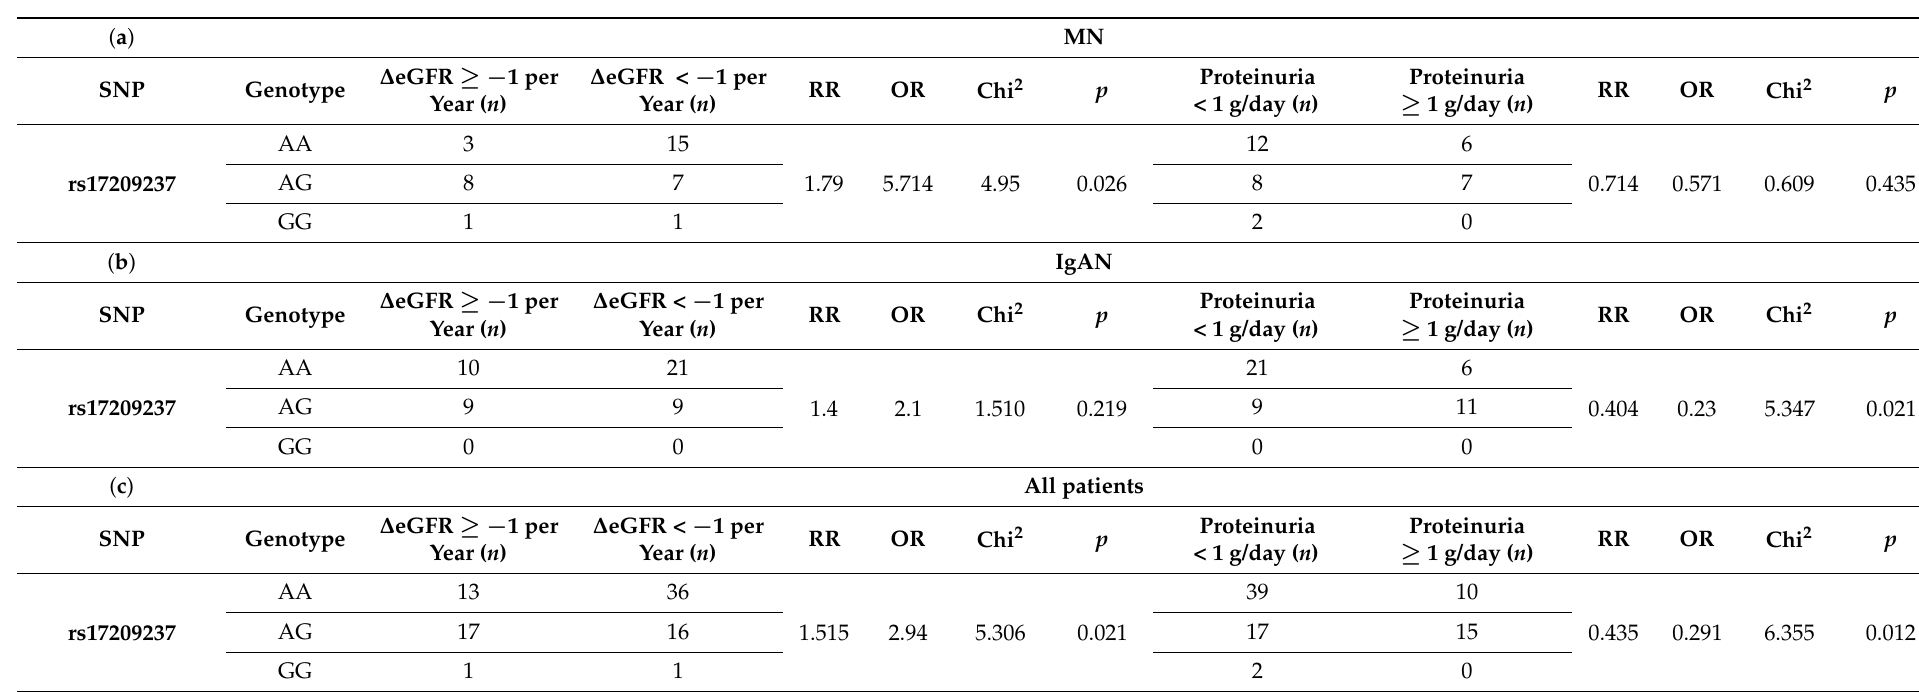
Table 6. The correlation between rs17209237 NR3C1 polymorphisms with ∆ eGFR (mL/min/1.73 m 2 /year) or proteinuria (g/day) after 1-year follow-up time in patients receiving steroid treatment for ( a ) MN; ( b ) IgAN; ( c ) all. Number of patients ( n